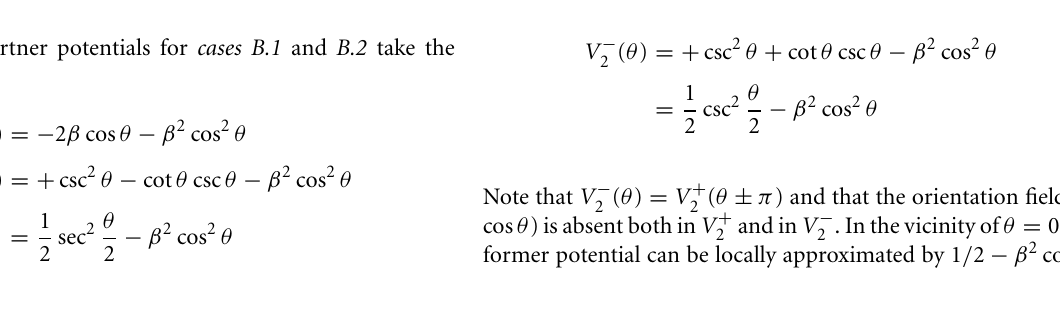
FIGURE 7 | Superpartner potentials V 1 (A) and V 2 (B), eigenenergies (dashed lines) and eigenfunctions (full curves) of Hamiltonian (Equation 1) with η = 5 ,ζ = 25, i.e., a first-order intersection with κ = 1, see section 3.1.